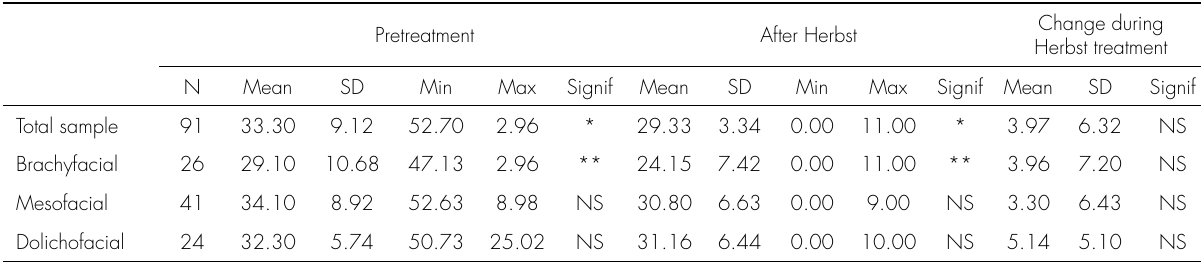
Table VI. Upper incisor to APog